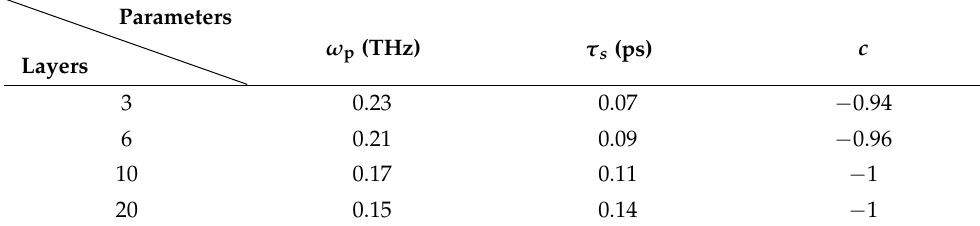
Table 1. Drude–Smith fitting parameters of different layers of PtSe 2 films.